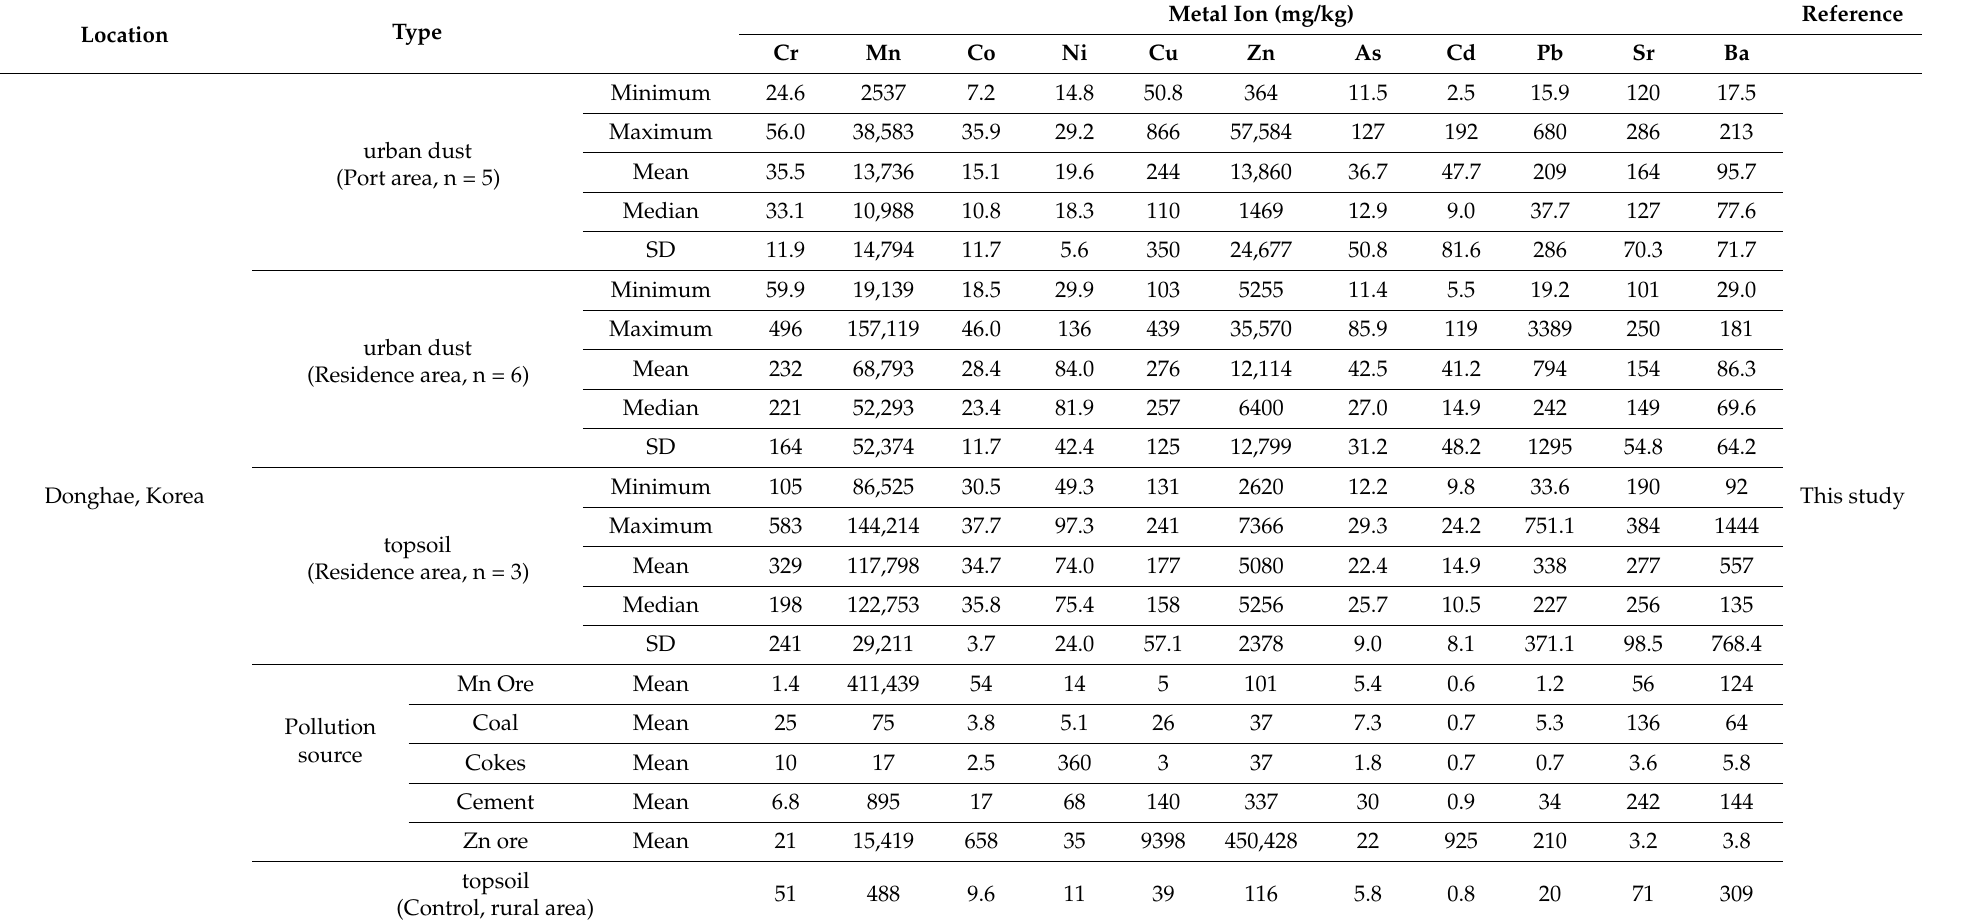
Table 1. Results of metal concentration in pollution source, control soil, and urban dust samples of this study and other literature values.